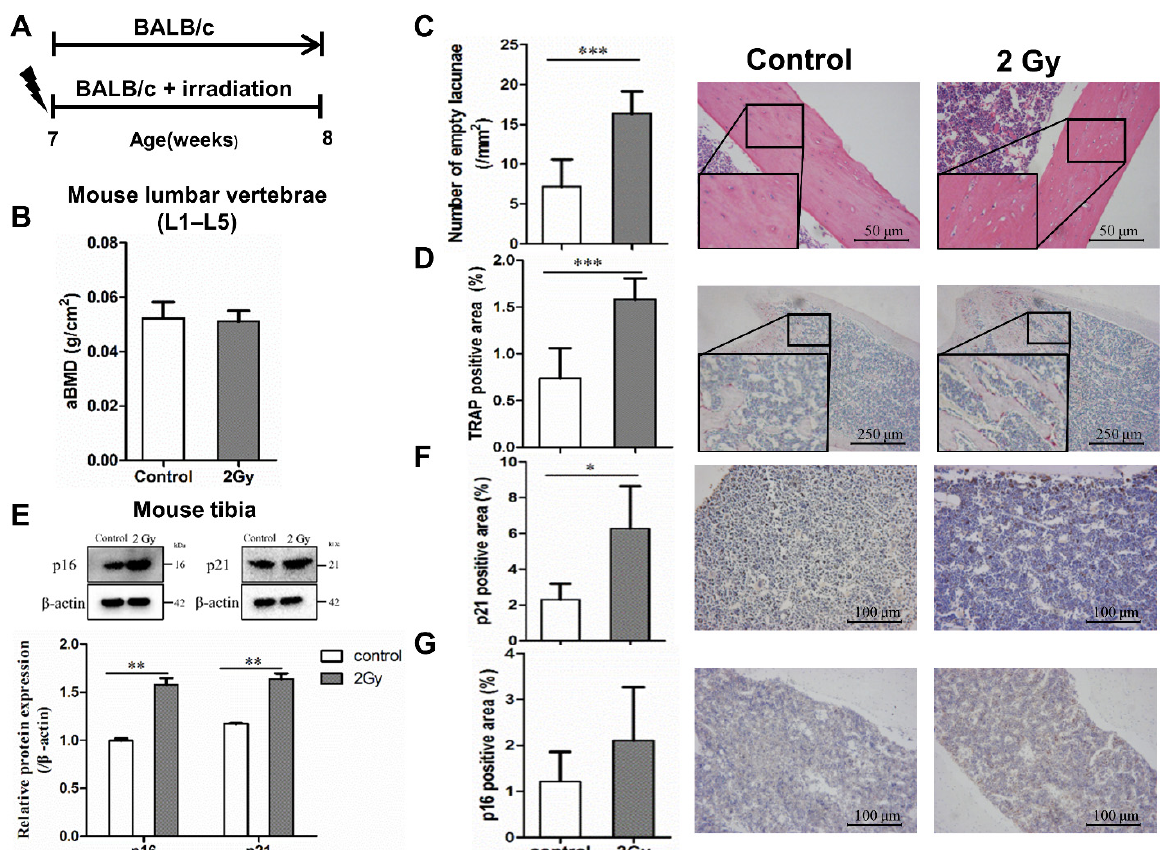
Figure 5. Radiation-induced bone tissue damage and aging. ( A ) Experimental design to test radiation-induced bone tissue senescence in mice. Effect of whole-body 2 Gy irradiation on aging-related bone loss. Seven week-old male BALB/c mice were randomized to receive a single 2 Gy irradiation ( n = 10) or no irradiation ( n = 10). The terminal observation time of the experiment was 7 days post irradiation. ( B ) Effect of single 2 Gy irradiation on the areal bone mineral density (aBMD) of the lumbar spine in mice; n = 8. ( C ) Effect of single 2 Gy irradiation on osteocyte lacunae in mice after 7 days; magnification = × 200, n = 6. ( D ) Effect of single 2 Gy irradiation on TRAP expression in mouse bone tissue after 7 days; magnification = ×40, n = 6. ( E ) The expression of senescence-related genes and proteins p21 and p16 in bone tissue was examined by Western blot analysis; n = 3. ( F , G ) The expression of senescence-related proteins p21 and p16 in mouse bone tissue 7 days post irradiation; magnification = ×100, n = 5. Results are expressed as mean ± SD (* p < 0.05; ** p < 0.01; *** p < 0.001 vs. control).